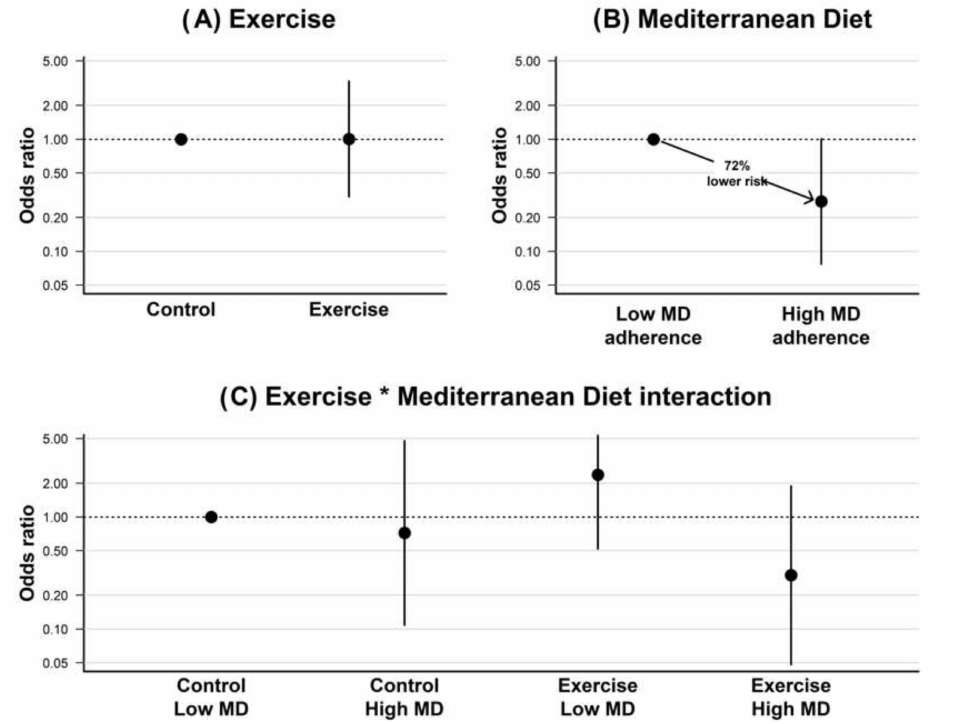
Figure 1. Odds ratio for postpartum depression relative to ( A ) experimental group (exercise vs. control), ( B ) Mediterranean diet adherence (above vs. below-median), and ( C ) the interaction between exercise and Mediterranean diet adherence. * represents the interaction